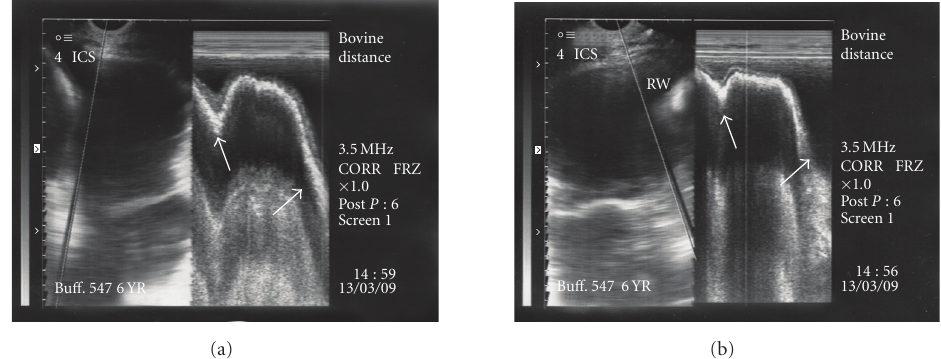
Figure 8: Complete biphasic reticular motility (arrows) evident in the thoracic cavity at the level of 4th intercostal space seen on B+M mode ultrasonograms confirmatory for diaphragmatic hernia.